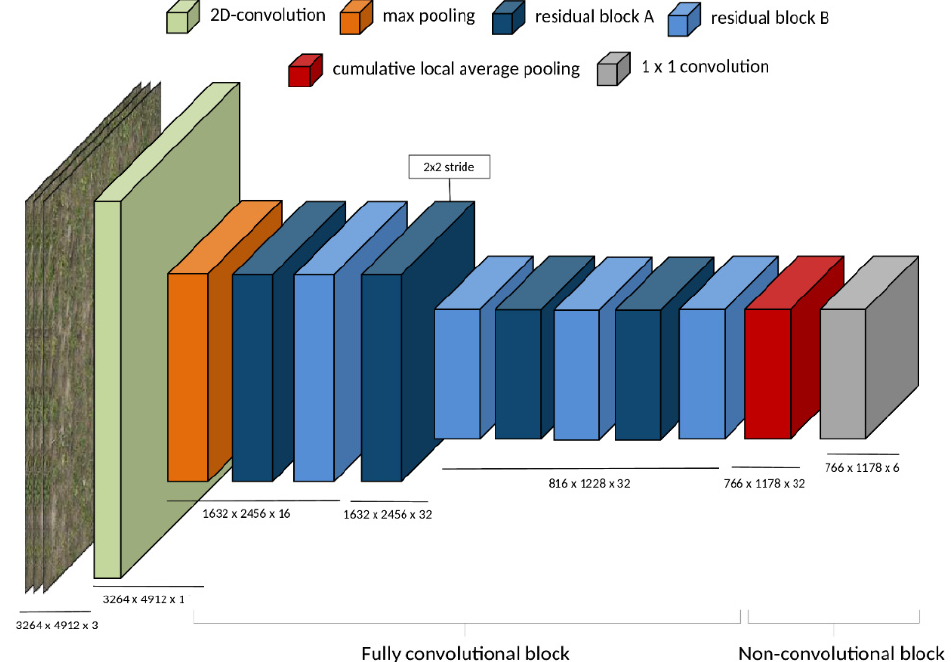
Figure 3. Architecture for image-level classifier derived from the patch-level model shown in Figure 1. Convolution and max pooling layers as well as residual blocks are identical to those in the patch-level model, except for their larger spatial dimension that results from the larger input size of the model. The cumulative local average pooling layer is a custom layer developed in this study and is described in Section 2.3. Together with the 1 × 1 convolution layer, it mimics the operation of the three last layers of the patch-level model (Figure 1) for each position in the grid. A 50 × 50 × 32 spatial patch from this 816 × 1228 × 32 output is essentially equivalent to the 50 × 50 × 32 output that would have been generated at the end of the last residual block in the original patch-level model if one had applied it to a particular 201 × 201 patch in the full image. However, the activation values in a 50 × 50 × 32 patch from the 816 × 1228 × 32 output are not exactly identical to the values one would get from the last residual block in the patch-level classifier applied to the corresponding 201 × 201 image patch. This is because the outer neurons in the 50 × 50 × 32 patch have a receptive field that covers more than 201 × 201 px in the input image. In the patch-level classifier, they would see borders that are padded with zeros, while in the image-level classifier they see pixels outside of the 201 × 201 area. However, all activations within the inner 20 × 20 spatial positions of the 50 × 50 × 32 patch are identical to the output of the 20 × 20 spatial cropping layer in the patch-level classifier, which is why the cropping layer was added to the patch-level classifier (see Section 2.2 and Figure 3). Note that there are 766 ×